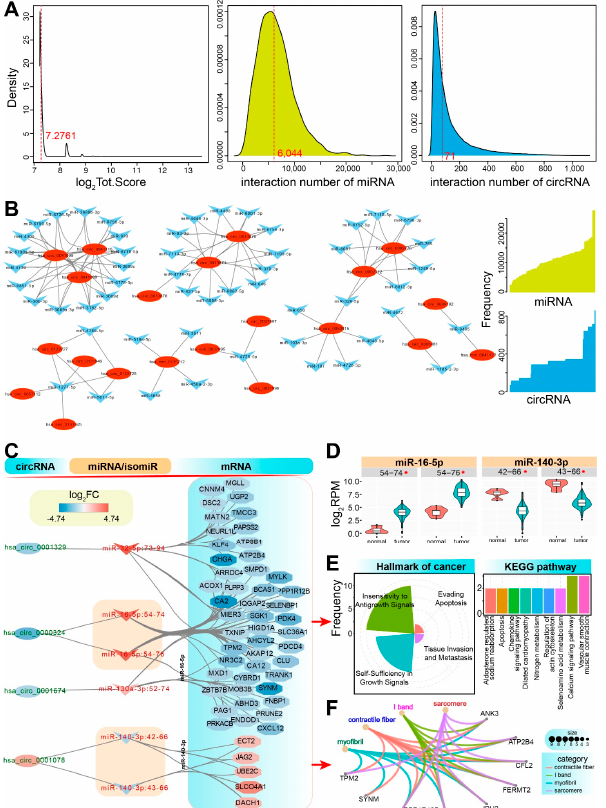
Figure 3. Widespread circRNA-associated ceRNAs and complex RNA interactions among different RNAs. ( A ) The distribution of scores of predicted candidate interactions between miRNAs and circRNAs is presented (data are obtained from Liu et al. [121]), and the median value of log 2 Score is 7.2761; the distribution of interaction number of miRNA, and the median interac- tion number is 6044; the distribution of interaction number of circRNA, and the median interaction number is 71. ( B ) An example of miRNA:circRNA interaction network shows the potential in- teractions between the two ncRNAs (all of them are detected with the higher scores). The real interaction number of miRNAs and circRNAs is also presented on the right. ( C ) An example of a potential circRNA-associated ceRNA network shows complex interactions among different RNAs in colorectal cancer. The dysregulated circRNAs are identified using GSE147597 data from the GEO database [124], and dysregulated relevant miRNAs/isomiRs (dominantly expressed) and some of their target mRNAs (dominantly expressed) are further obtained from TCGA-COAD. The miRNA:mRNA interactions are obtained from the starBase database [125,126], and all of these in- teractions are predicted by at least 3 algorithms. The detailed multiple isomiRs are presented in the network according to the detailed start and end positions on the chromosome. miR-32-5p:73-94 indicates the detailed location of hg38:chr9:109046273-109046294: − of isomiR in miR-32-5p locus; miR-16-5p:54-74 indicates hg38:chr3:160404754-160404774:+ (mir-16-2 precursor) of isomiR in miR- 16-5p locus; miR-130a-3p:52-74 indicates hg38:chr11:57641252-57641274:+ of isomiR in miR-130a-3p locus; miR-140-3p:42-66 indicates hg38:chr16:69933142-69933166:+ of isomiR in miR-140-3p locus. These candidate interactions only present the biological relationships and dysregulated expression patterns as examples, and expression correlations are not estimated due to limited data; ( D ) The detailed expression distributions of isomiRs in miR-16-5p and miR-140-3p loci between tumor and normal samples. All of them are significantly up-regulated or down-regulated in tumor samples. * indicates log 2 FC > 1.5 and padj < 0.05 or log 2 FC < − 1.5 and padj < 0.05; ( E ) According to involved target mRNAs in Figure 3C, primary functional analysis is performed, mainly including the potential contributions in hallmarks of cancer and KEGG pathways; ( F ) Functional enrichment analysis is performed using clusterProfiler